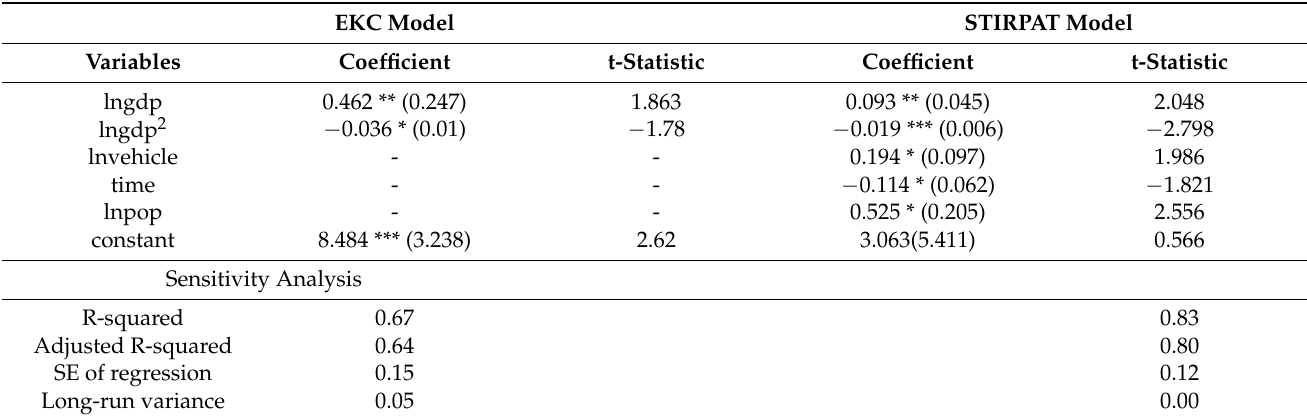
Table 3. Result of EKC and STIRPAT model (FM-OLS